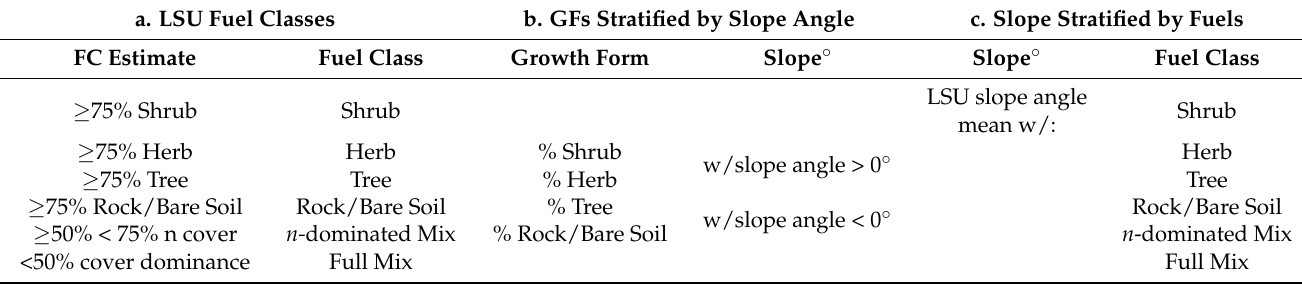
Table 2. Explanatory variable classification and stratification schemes. ( a ) Growth form fractional cover estimates classifica- tion procedure (LSU fuel classes); ( b ) growth form fractions stratified by slope orientation; ( c ) slope angle means stratified by